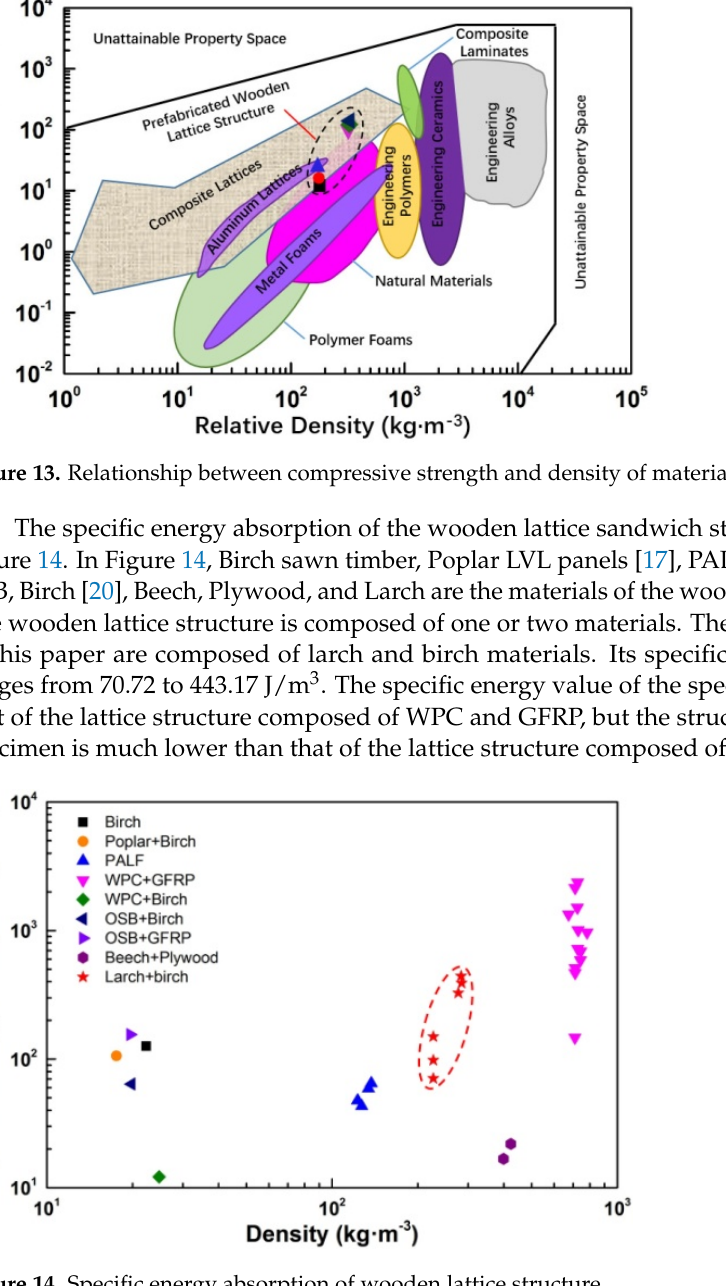
Figure 14. Specific energy absorption of wooden lattice structure.